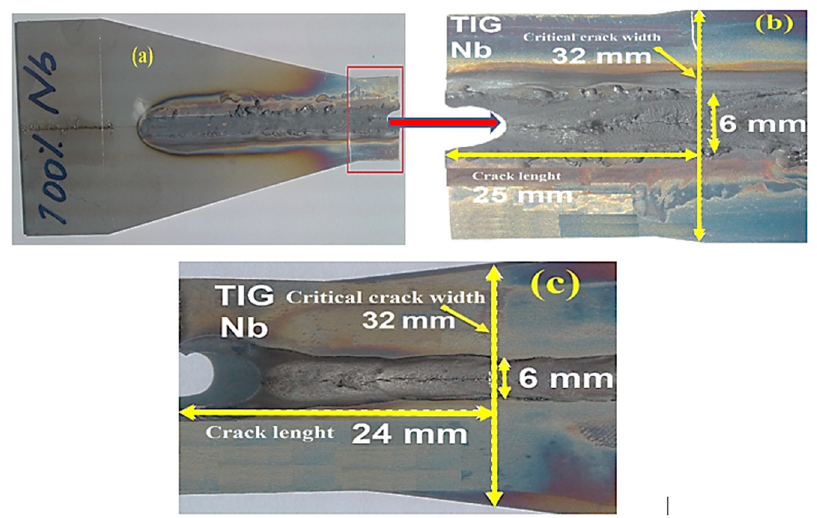
Figure 6. Welded specimen coated with Nb powders, face side ( a ), enlarged of marked area ( b ) and back side of enlarged marked area ( c ).